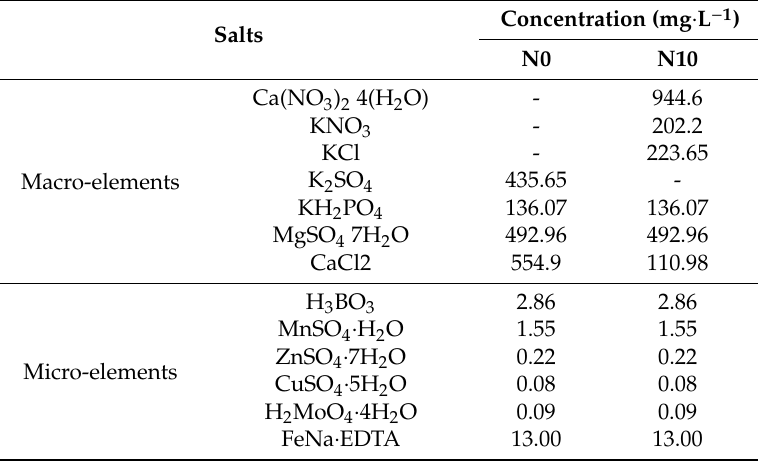
Table 1. Components of macro- and micro-elements in nutrient